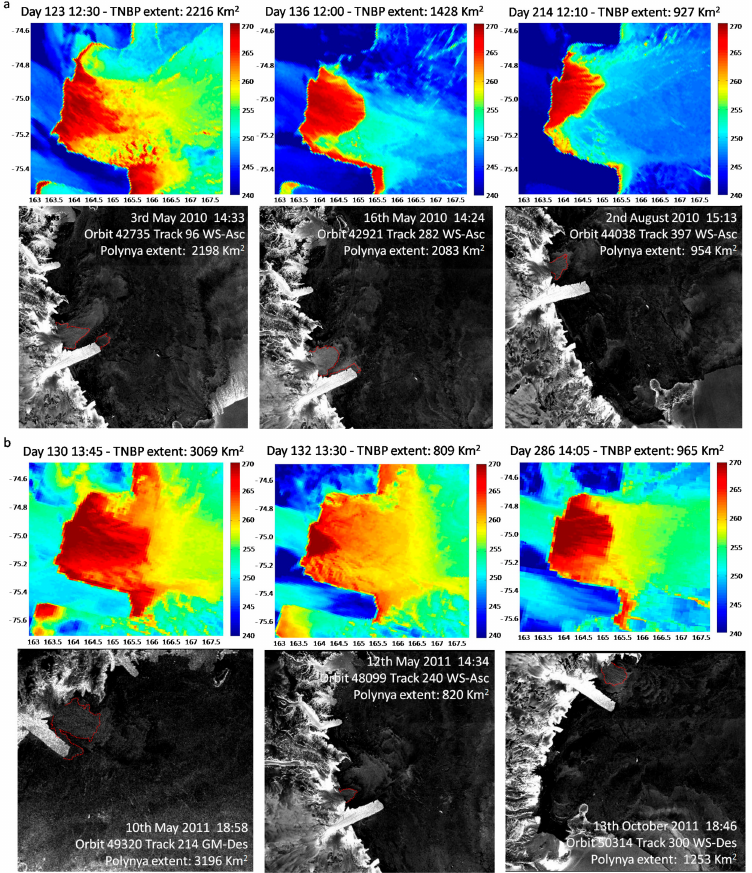
Figure 8. Examples of Terra Nova Bay polynya extents retrieved through MODIS IST scenes and co-located ASAR ENVISAT imagery during winter season ( a ) 2010 and ( b ) 2011. Red dashed lines identify the polynya area as visually recognized for extent computation in ASAR